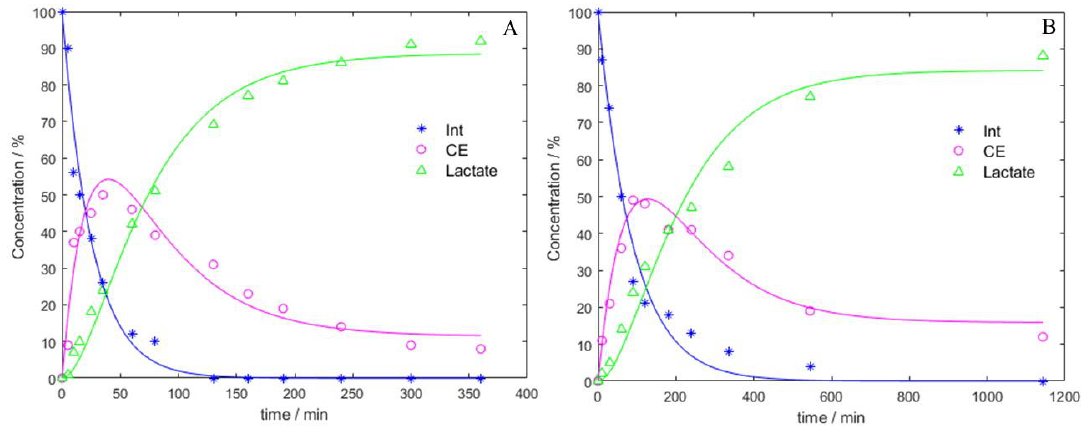
Figure 3. Reaction profiles obtained from NMR data for alcoholysis at 110 °C with Zn( 1 ) 2 . ( A) EtLa and ( B) BuLa.